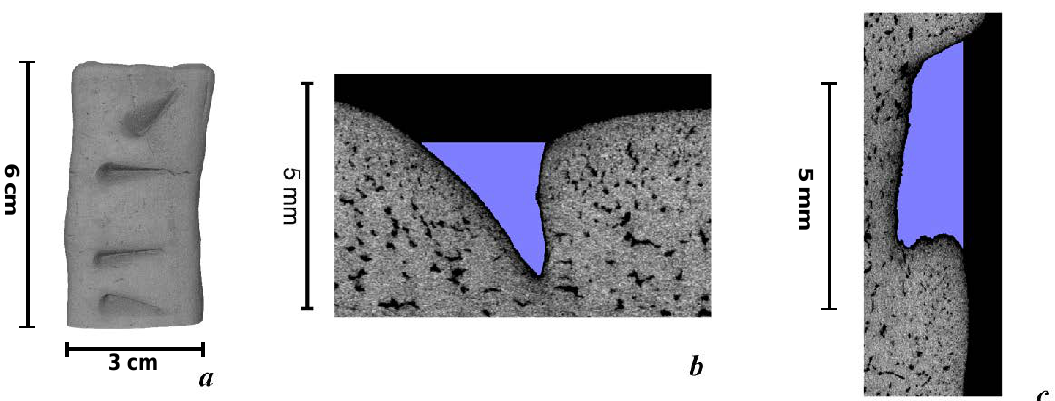
Figure 3. Virtual reconstructed model: ( a ) 3D virtual model of hit tracks in the plasticine obtained from the battle axe from the Malo-Kizylski site, resolution 180; ( b ) virtual transverse slice of the battle axe imprint; ( c ) virtual longitudinal slice of the battle axe imprint, resolution 70 µ